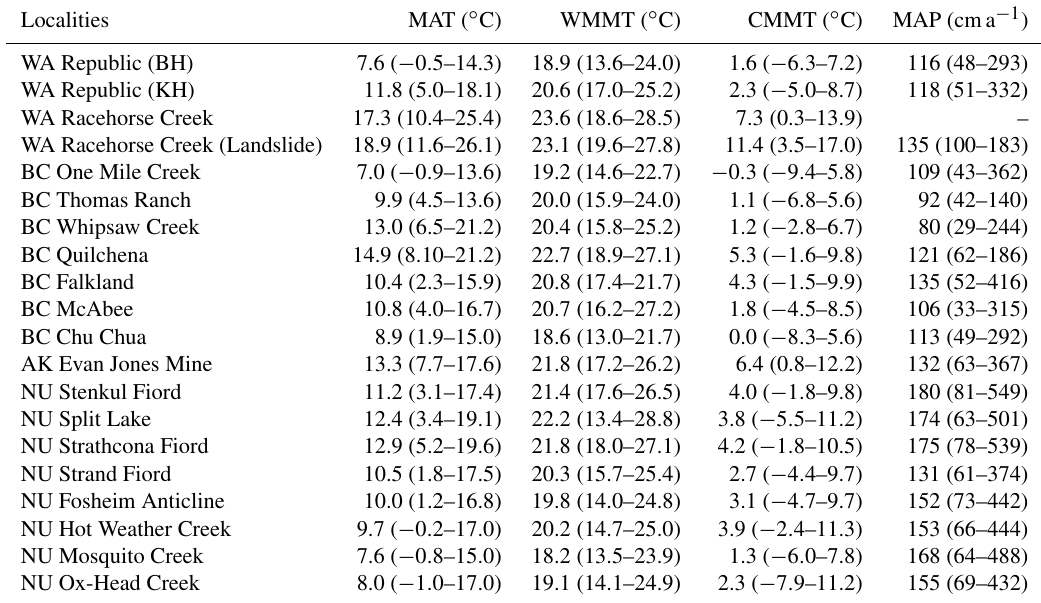
Table 2. Proxy ensemble climate estimates for fossil plant localities. The bracketed range indicates the 95% confidence interval of the bootstrapped paleobotanical proxy estimates. BC – British Columbia, Canada; NU – Nunavut, Canada; WA – Washington, USA; AK – Alaska, USA; BH – Boot Hill; KH – Knob